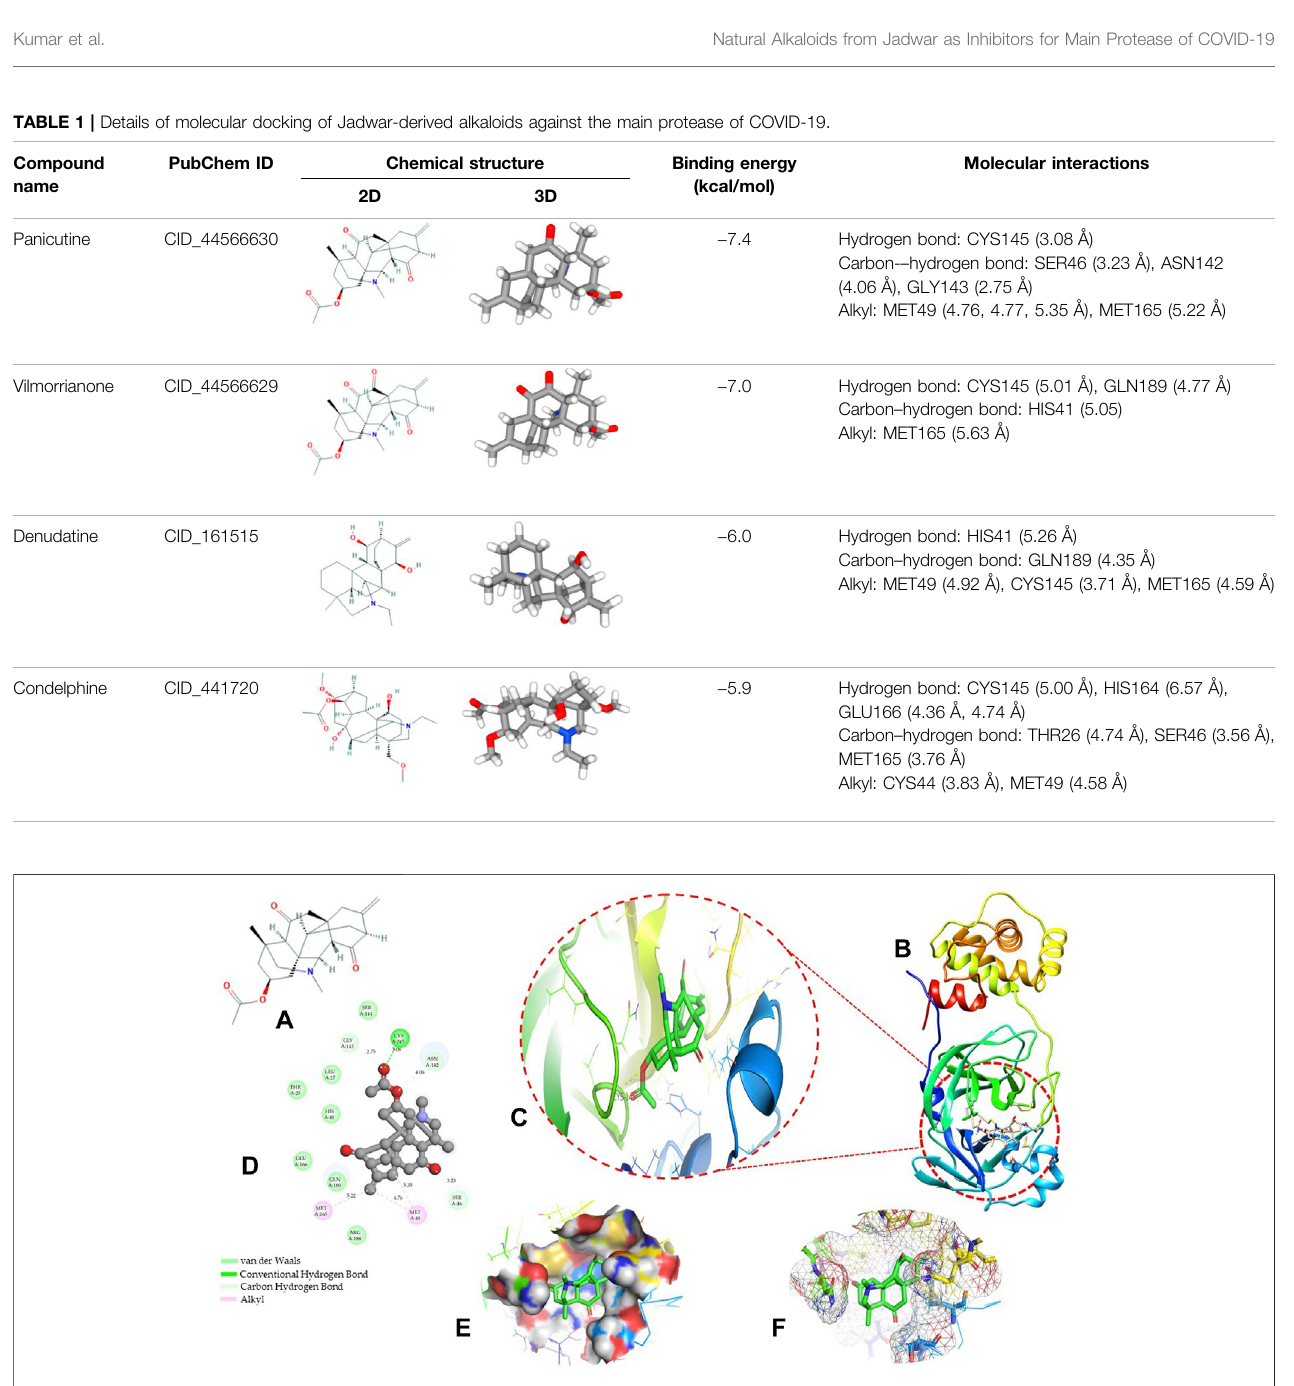
Frontiers in Molecular Biosciences |